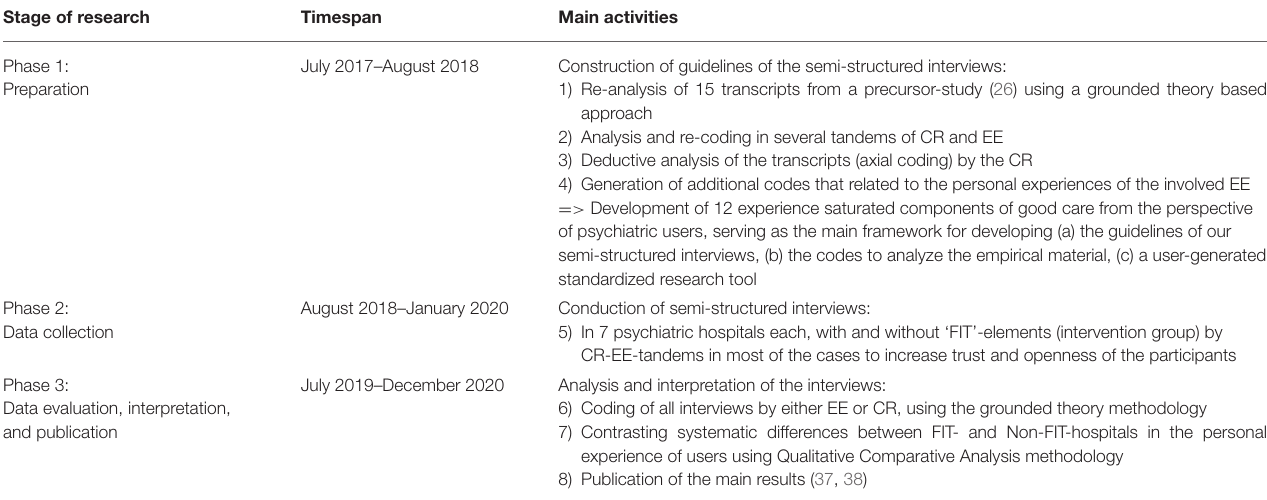
TABLE 1 | Schedule of collaborative process